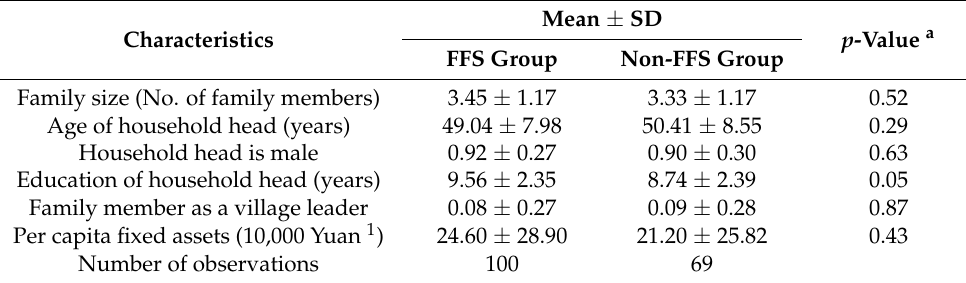
Table 2. Comparison of household characteristics between FFS group and non-FFS group. Characteristics